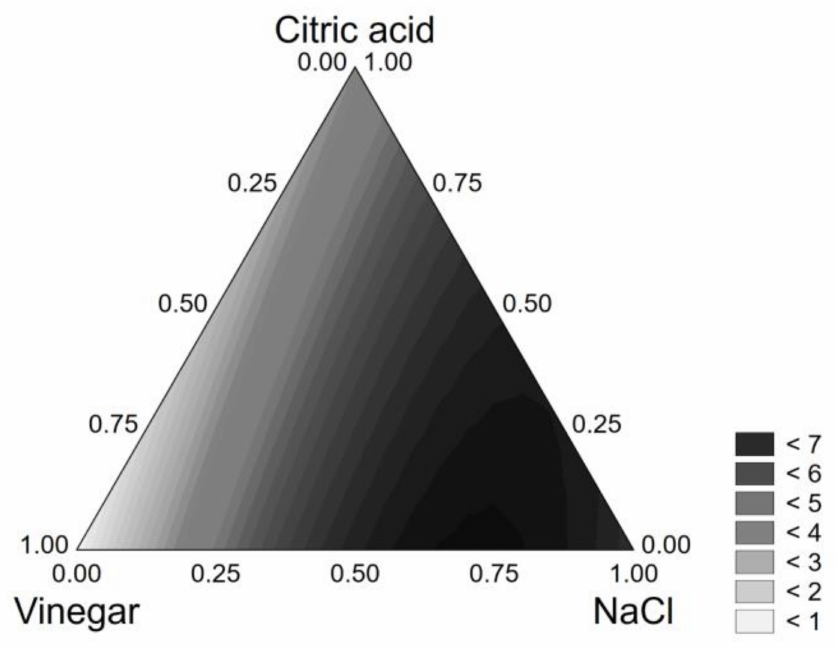
Figure 1. Ternary plot for the viability loss of L. plantarum 69 after 24 h in the model system. The same modelling approach was used for the other strains. For L. plantarum 68, NaCl was significant as an individual term and in interaction with the vinegar; in this case, the least significant variable was vinegar. The polynomial equation reads as follows: VL = 1.414[ V ] + 2.998[ NaCl ] + 6.264[ CA ] + 9.706[ V ][ NaCl ] + 8.080[ NaCl ][ CA ] (R 2 , 0.922) For this strain, the highest viability loss (6 log CFU/g) was found for the combination NaCl + citric acid, both at the coded level 0.5 (6% NaCl + 0.75% citric acid) (Figure 2).